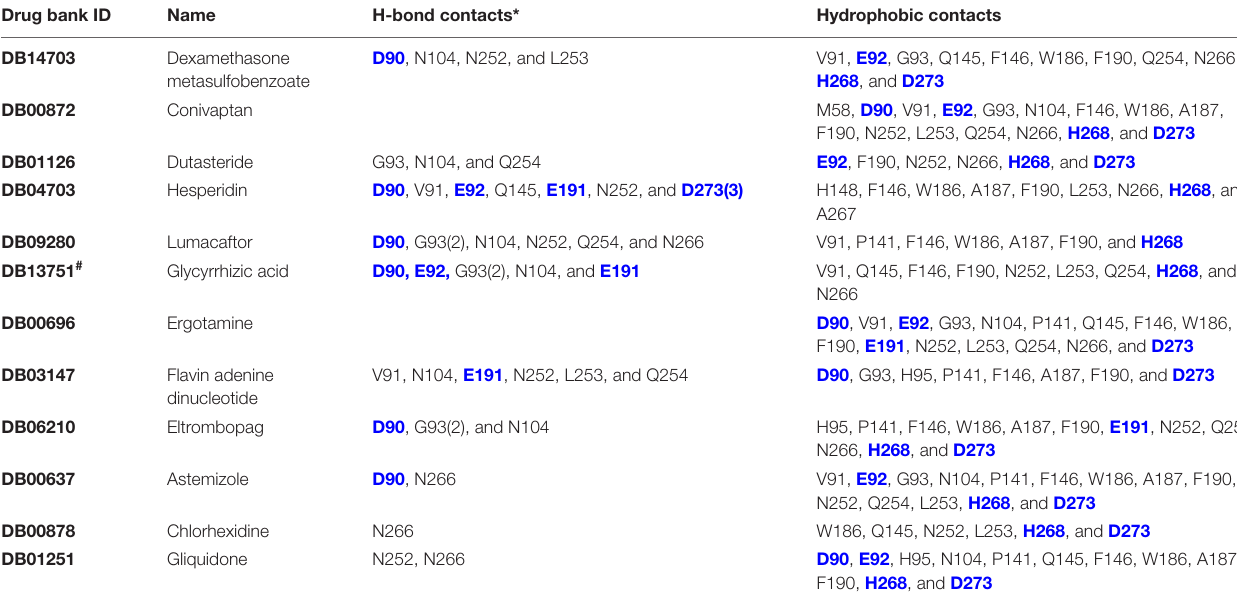
LigPlus did not work, manually done.